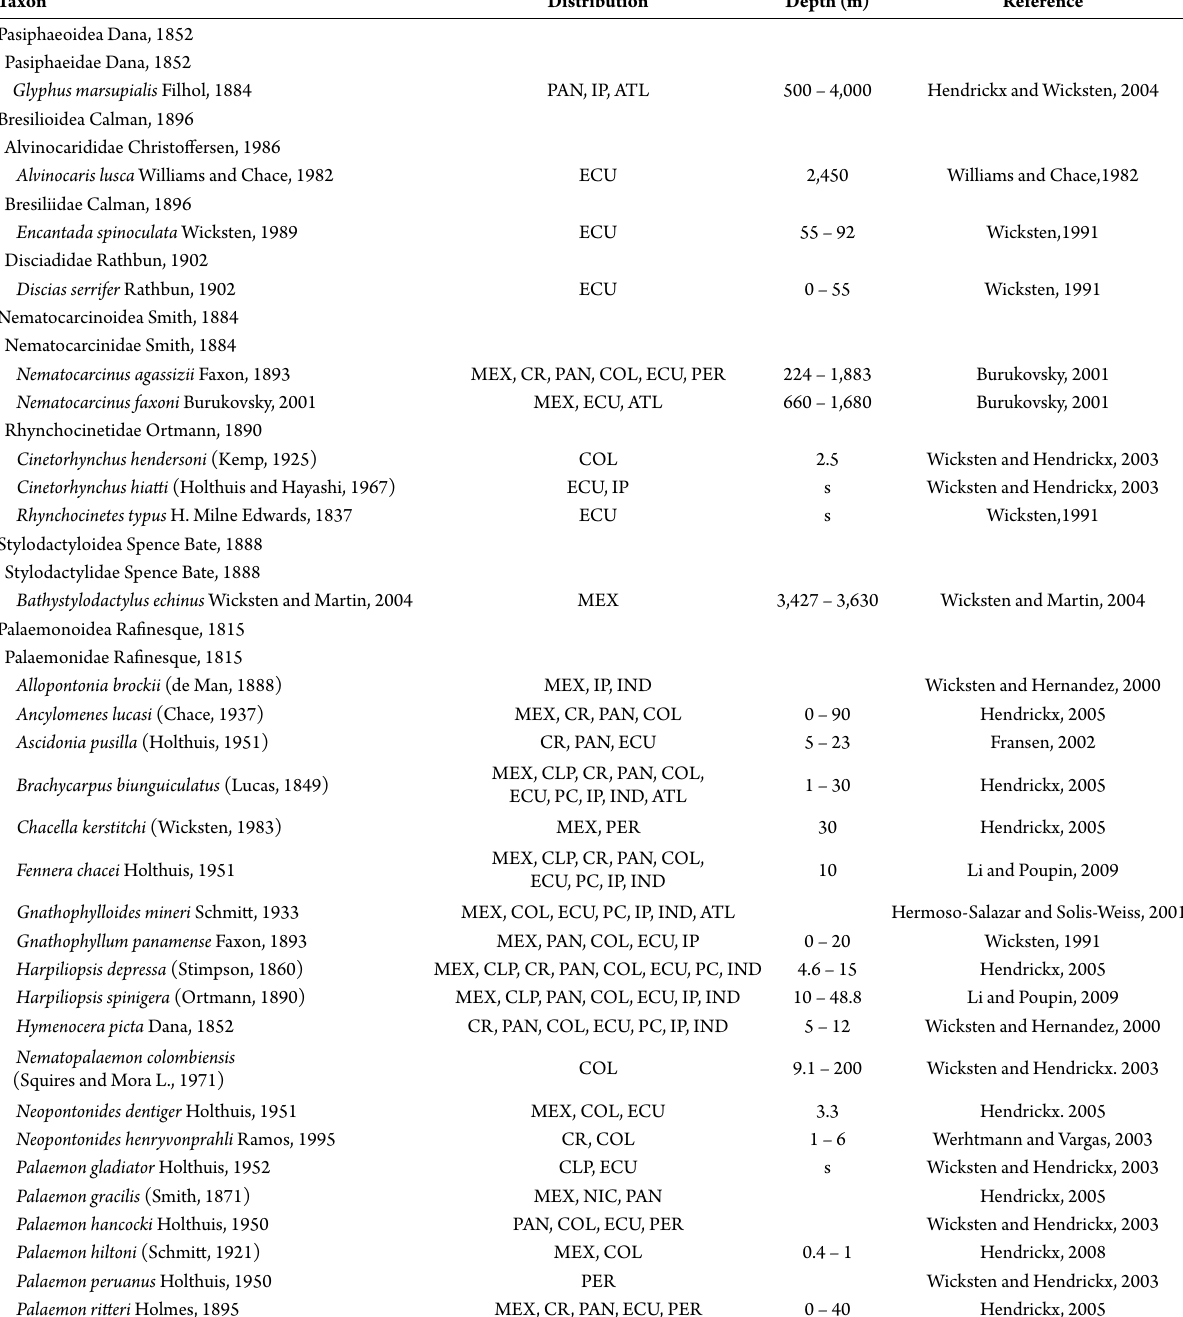
Table 1. Checklist of marine benthic caridean shrimps from the Tropical Eastern Pacific. Systematic arrangement follows De Grave and Fransen (2011). Mexico-Revillagigedo: MEX, Clipperton: CLP, El Salvador: SAL, Nicaragua: NIC, Costa Rica: CR, Panama: PAN, Colombia-Malpelo: COL, Ecuador-Galapagos: ECU, Peru: PER, Central Pacific: PC, Indopacific: IP, Indian: IND, Atlantic: ATL, s: